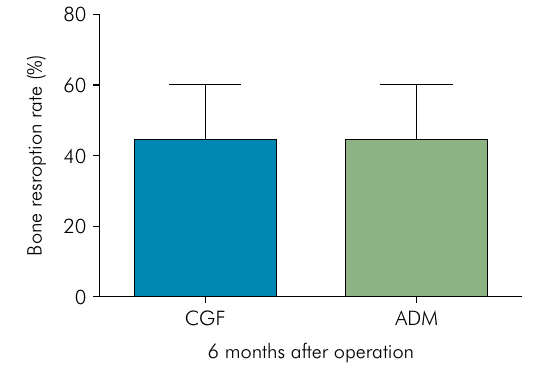
Figure 2. Comparison of the bone density improvement rate between the CGF group and the ADM group at 6 months after alveolar bone grafting (p >